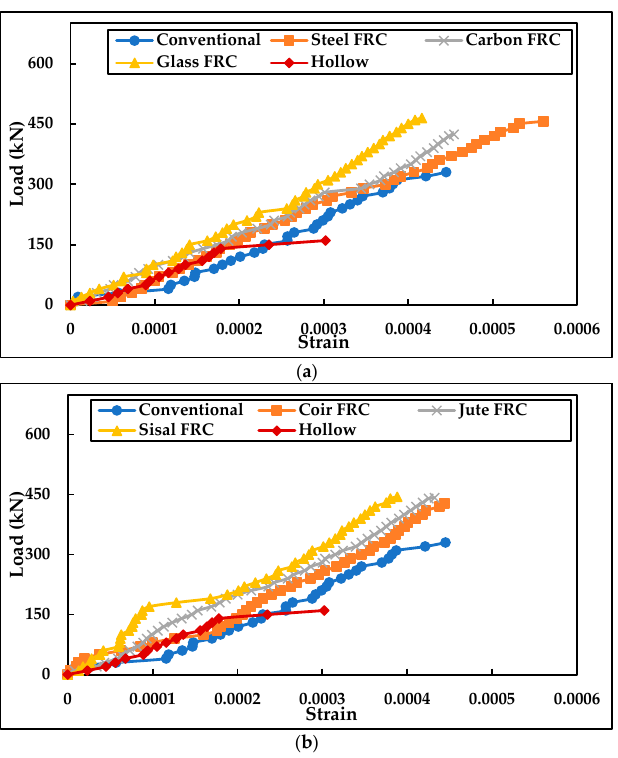
Figure 15. Graphical illustration of load vs. strain. ( a ) Artificial FRC, ( b ) Natural FRC. Similarly, the axial shortening of the columns with the implementation of carbon, coir and sisal FRC infills was observed to be less than columns with other types of fibre- reinforced concrete infills. Comparing rectangular steel columns filled with steel, carbon, and glass FRC to those filled with ordinary concrete, the percentage decrease in axial shortening was found to be 4.98%, 13.84%, and 7.40%, respectively. Comparing coir, jute, and sisal FRC-infilled rectangular steel columns to conventional concrete-filled steel tub- ular columns, the percentage decrease in axial shortening was found to be 20.28%, 8.06%, and 12.67%, respectively. The graphical representation of load vs. axial shortening for hol- low medium columns and medium columns with various types of concrete infills is shown in Figure 16. In medium columns, the failure occurred with the overall buckling of the column, as shown in Figure 17. Table 4 displays the ductility index of several concrete- filled steel tubular columns.